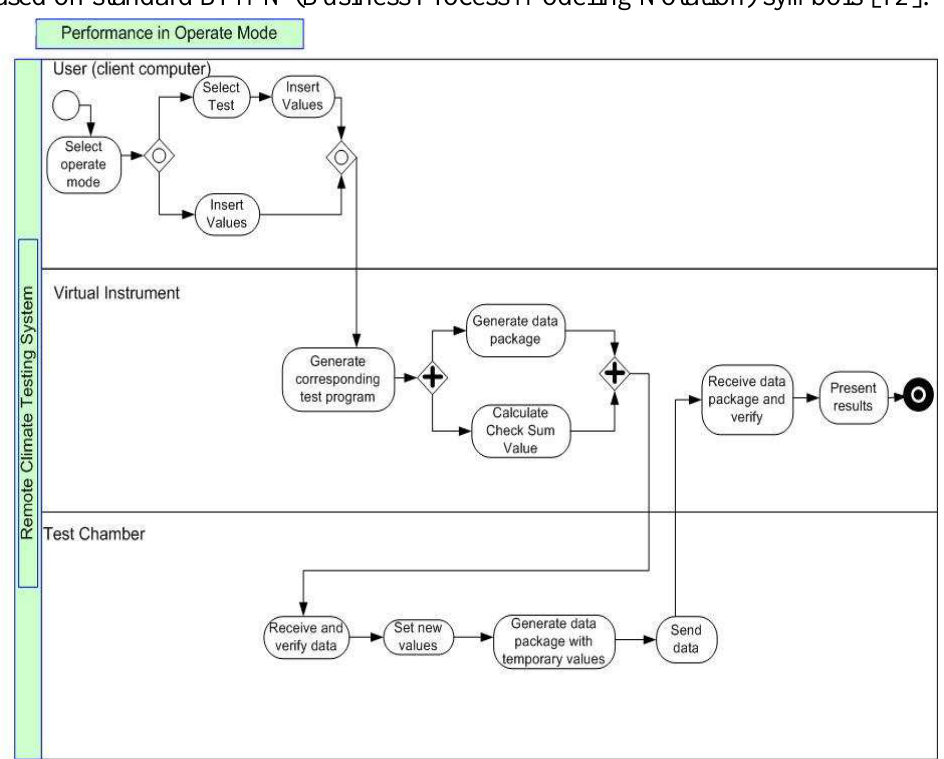
Figure 6. Brief presentation of essential data transfer and task sequence of Remote Control System based on standard BPMN (Business Process Modeling Notation) symbols